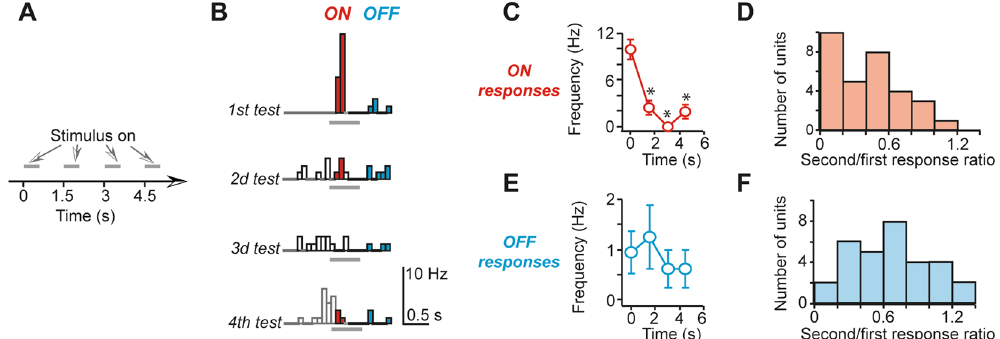
Figure 1. In rat collicular neurons responses to visual stimuli gradually diminished during repeated presentations. ( A ) The schematics of stimulation protocol. ( B ) Peristimulus time histograms (PSTHs) of response to multiple presentations. Red and blue bars correspond to bins used to calculate ON and OFF responses correspondingly that occur during stimulus onset (‘ON’) and offset (‘OFF’). 8 tests were used to build the histograms. ( C ) The average action potential frequency during ON responses of a single unit shown in ( B ). Each open circle corresponds to an average AP frequency during ON response to a stimulus presented at a time point shown on the horizontal axis. ( D ) The distribution among recorded units of 2d/1st response AP frequency ratio. ( E , F ) The same as C and D correspondingly but for OFF